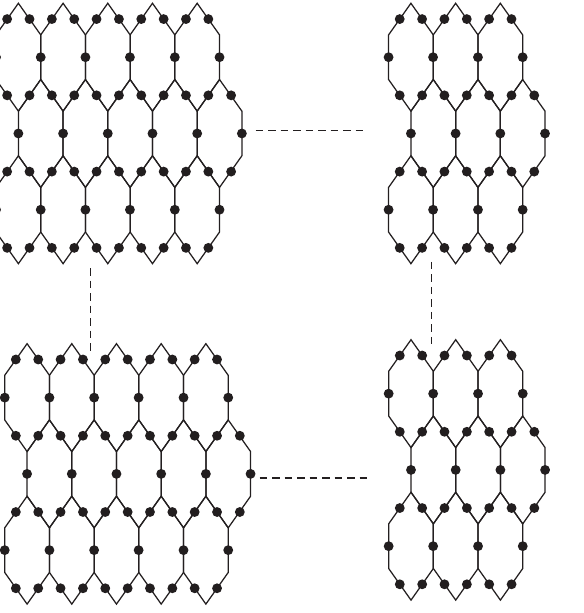
Figure 2: Subdivision graph of G t,s . Figure 3: Line graph of the subdivision graph of G t,s